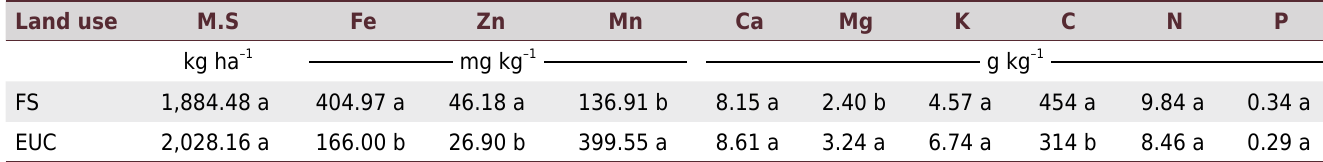
C: extracted and determined by the Walkley-Black method adapted using 250 g of crushed soil and HNO 3 (65 %) and H 2 O 2 (30 %) as reagents; N: Kjeldahl method; total of macro (Ca, Mg, K, and P) and micronutrients (Fe, Zn, and Mn) digestion by nitric-perchloric method. Values followed by the same letter in the columns indicate absence of statistical difference. n =